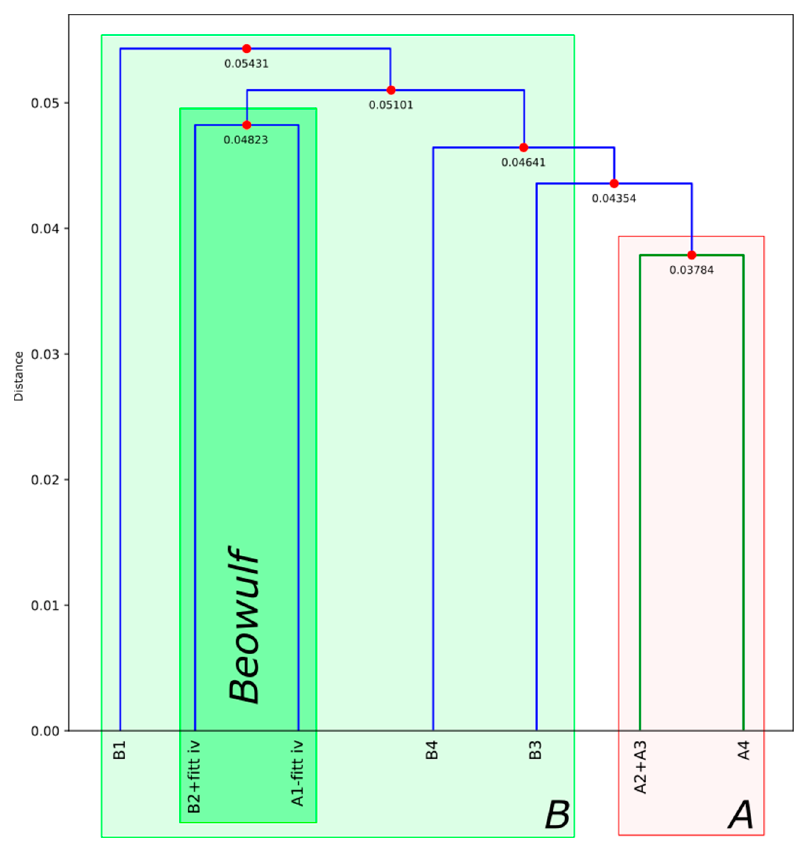
Figure 12. Dendrogram of the blended sections.